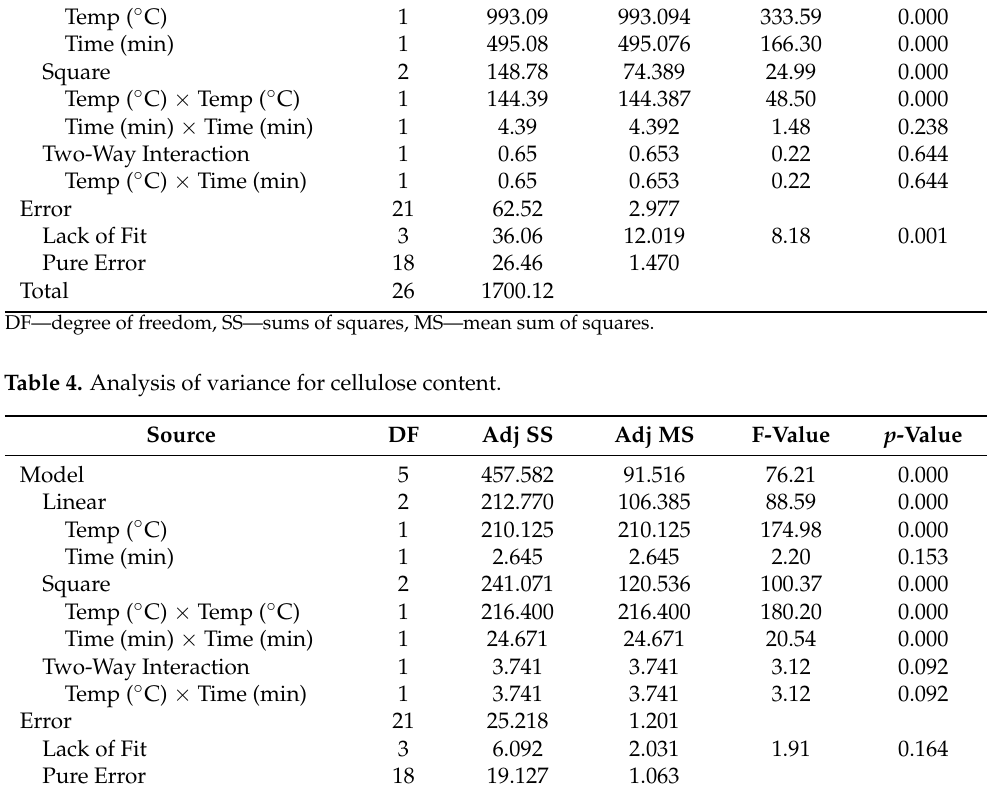
Table 4. Analysis of variance for cellulose content.